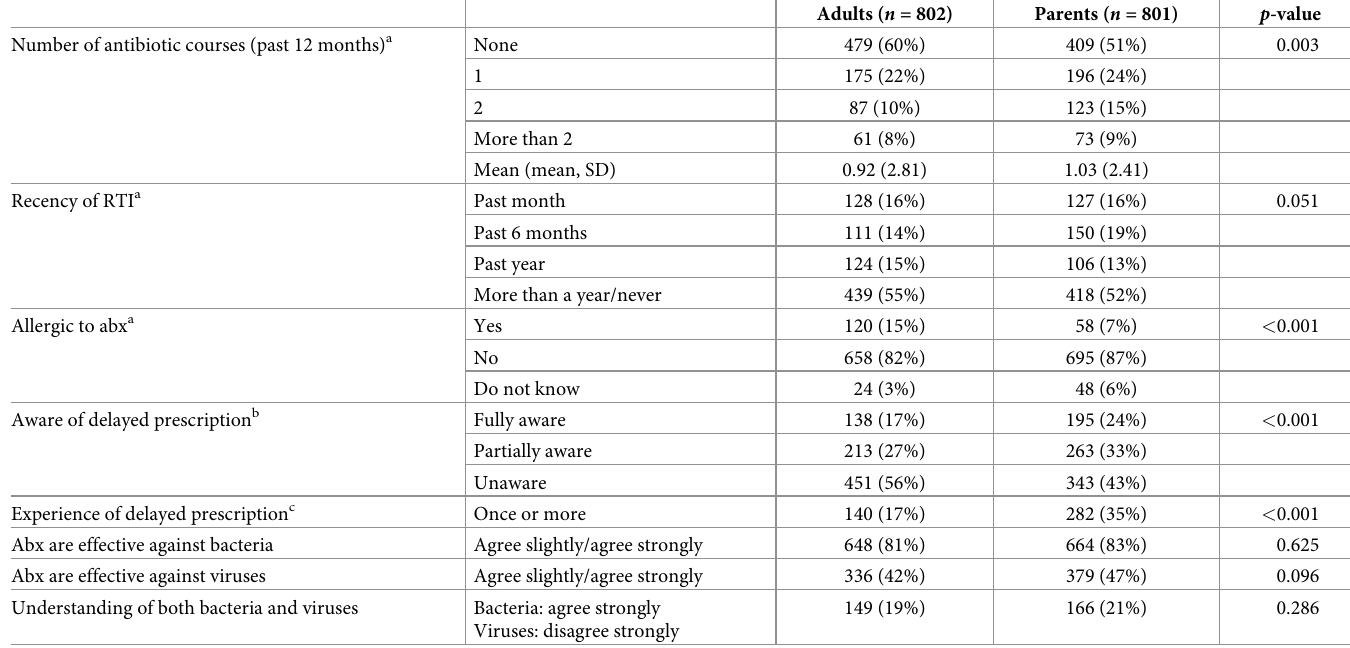
Table 3. Antibiotic experience and